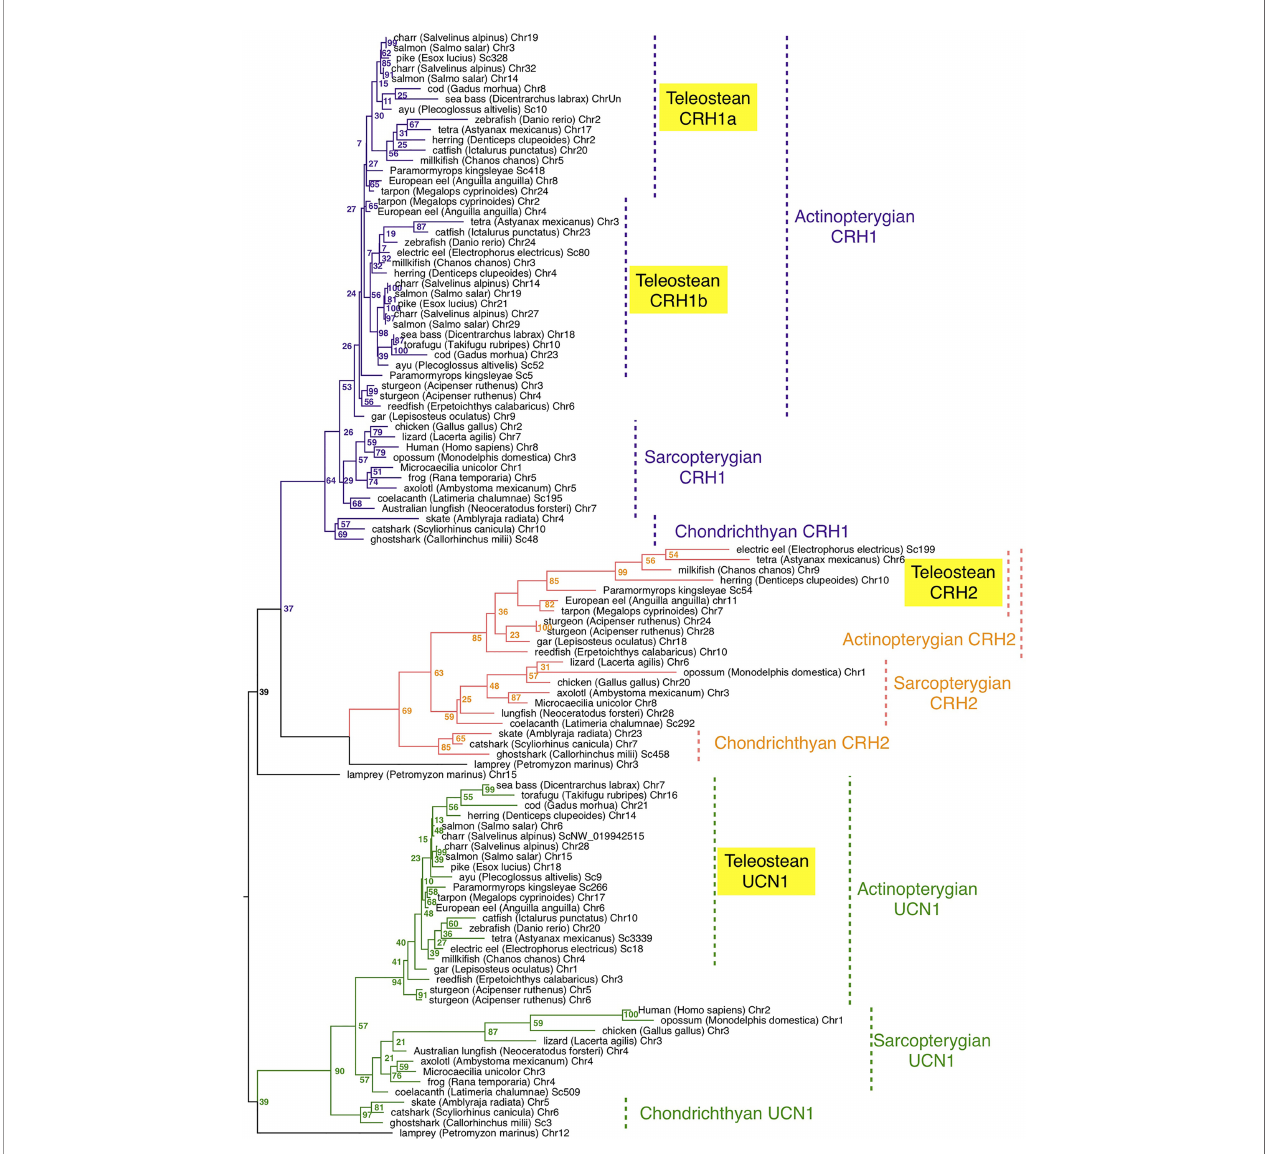
FIGURE 1 | Maximum-likelihood phylogenetic tree of CRH prepropeptide amino acid sequences of vertebrate representatives. Phylogenetic relationships of CRH was inferred using the PhyML algorithm with the WAG substitution matrix and the best nearest neighbour interchange (NNI) and Subtree Pruning and Regrafting (SPR) improvement algorithm. Numbers at the node indicate the con fi dence percent of 100 bootstrap replications. The three gnathostome monophyletic clades are indicated with different branch colors and the corresponding CRH clade names are indicated using the same colour. Taxonomic group names are indicated at the right of the tree. The list of corresponding gene references is provided in Table S1